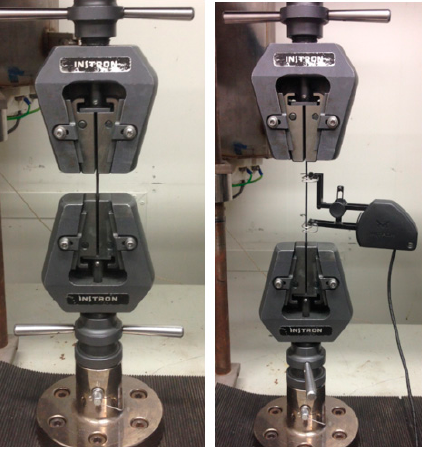
Figure 7. Setup of a dog bone specimen ( left ) and filament ( right ), with the extensometer